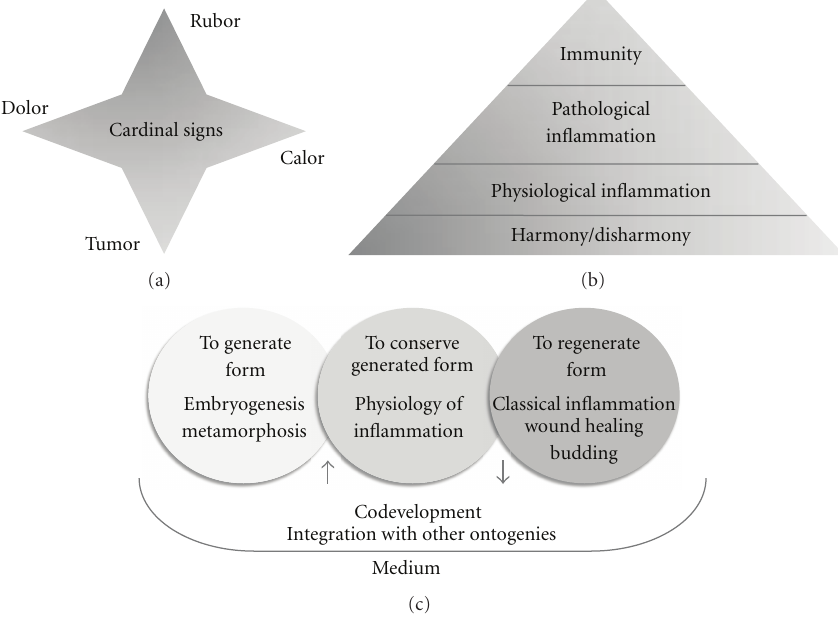
Figure 2: Inflammation in the eye of the observer. Since its origins, inflammation has frequently been viewed as a collection of signals (a). In this context, what is studied is not a biological process but the results of a process that remains ignored. According to Metchniko ff , however, inflammation and immunity are particular instances of a broader process of animal harmony generation ((b), adapted from Tauber [37]). Because the same mechanisms involved in pathology were also involved in embryogenesis, Metchniko ff coined the term physiological inflammation, which he claimed preceded the problem of pathological inflammation. A modern reinterpretation of this developmental contextualization of inflammation could be represented as in (c). Thus, the genesis of form, its conservation, and its regeneration are problems of the same nature, which deal with the construction of an organism even when examining the animal/microbiota interaction.